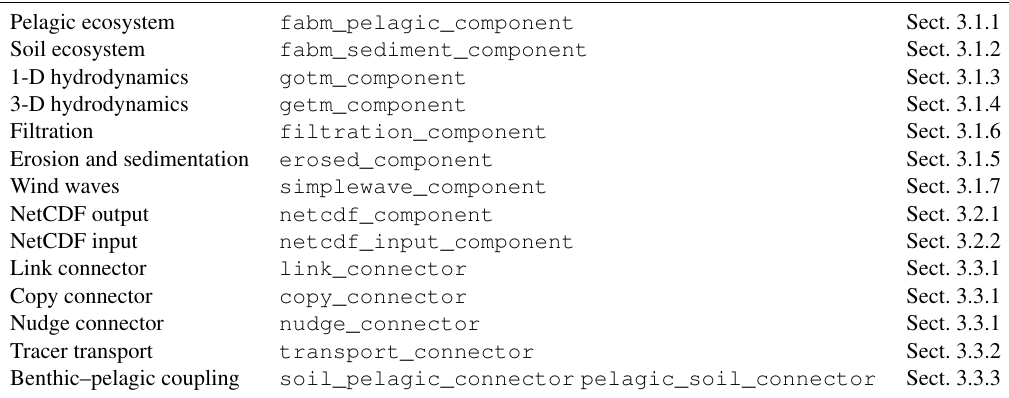
Figure 3. Examples of coupling configurations (a, b) and the steps from installation to deployment (c) . The configurations exhibit a minimal default coupling specification (a) and a more complex one ( b , see Fig. 2) that makes use of dependencies, instantiation, and different coupling intervals. The line-numbered installation steps (c) include environment variable specification ( export ), download of the system with git , loading additional external models with make , installation of the mossco executable script, and finally deployment of the coupling specification jfs in a predefined set-up called “helgoland”, a 1-D station near the island of Helgoland in the southern North Sea. Table 1. Components currently integrated into MOSSCO and described shortly in this paper. Several other components are under develop- ment and not listed